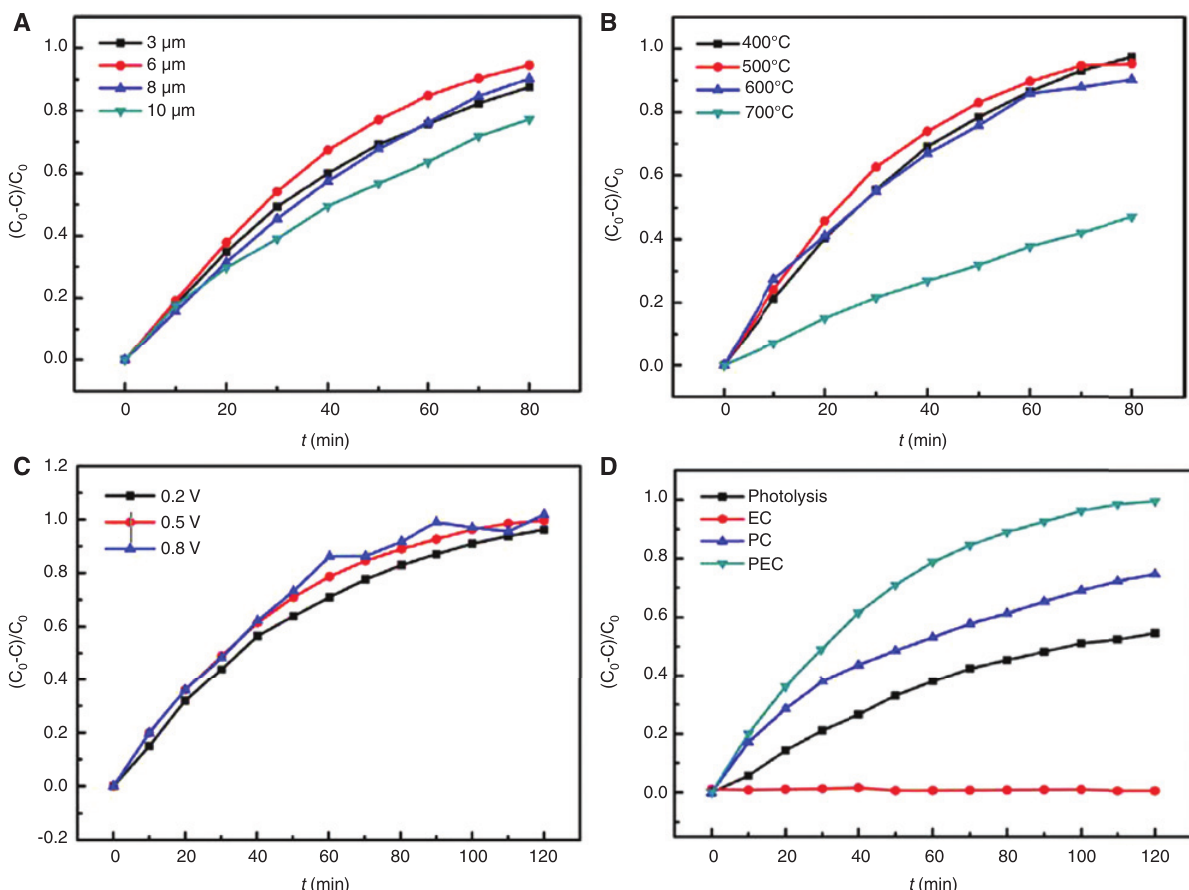
NTAs length (A) and annealing temperature (B) on salicylic acid degradation in photoelectrocatalysis process at Figure 22: Effect of TiO 2 0.5 V. Effect of bias potential on salicylic acid degradation in photoelectrocatalysis process with 6 μ m length and annealed at 500 ° C (C). Comparison of salicylic acid degradation ratios under different situations (D). C certain reaction time. Reproduced from Ref. [231] with permission. Copyright